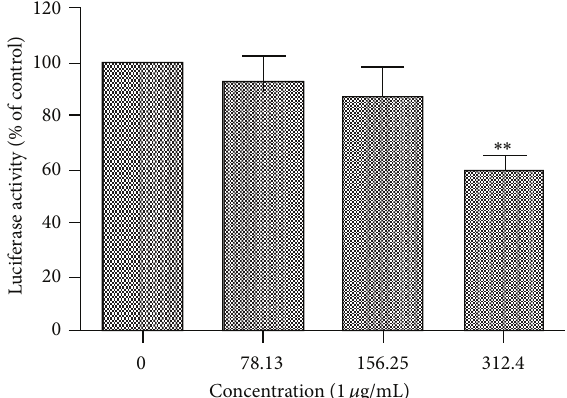
Figure 6: NF- 𝜅 B transcription activity versus the concentrations of Ximenia caffra leaf extract after